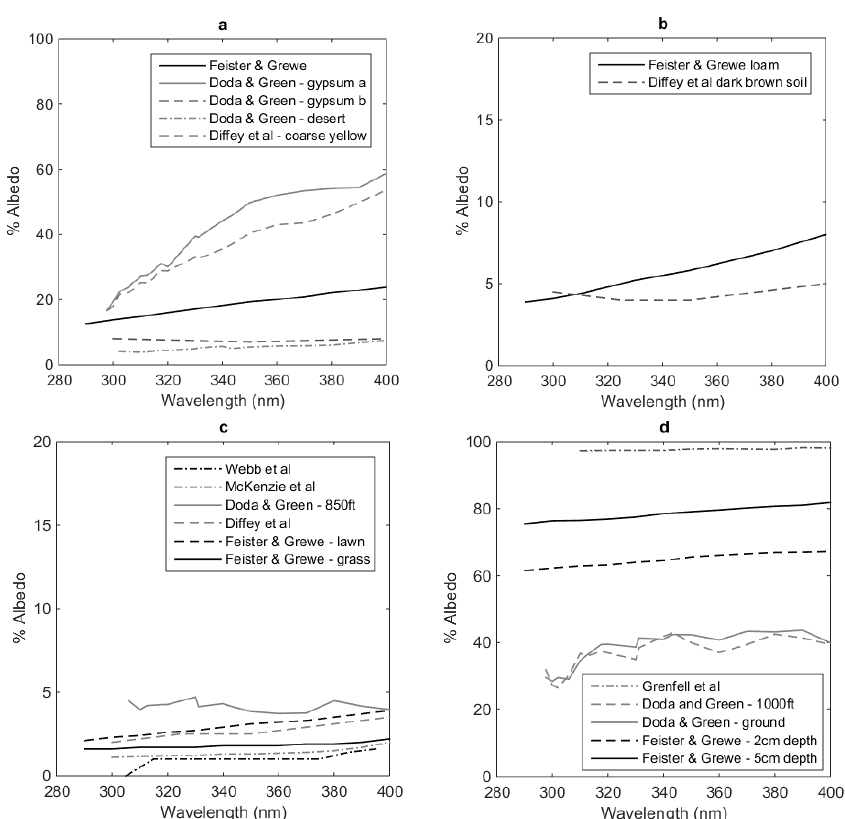
Figure 1. Spectral UV albedo for ( a ) sand, ( b ) earth, ( c ) grass and ( d ) snow. The data has been collated from Feister and Grewe [27], Doda and Green [44,45], Diffey et al. [26], Webb et al. [36], Grenfell et al. [37] and McKenzie et al. [32].